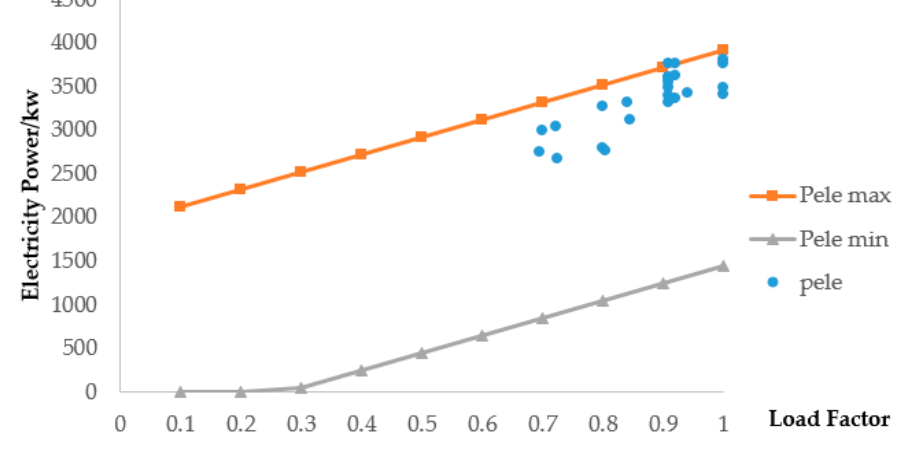
Figure 17. Single time scale power load-load rate operation.